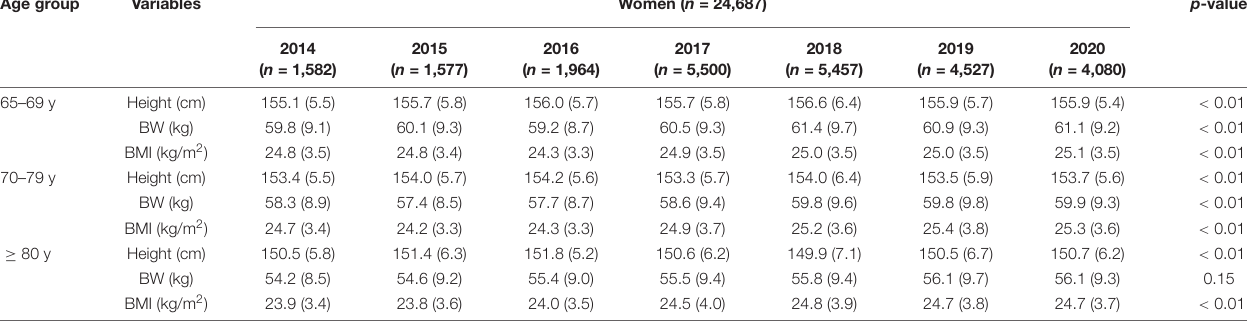
TABLE 1B | General characteristics of 24,687 Chinese aged women from 2014 to 2020. Age